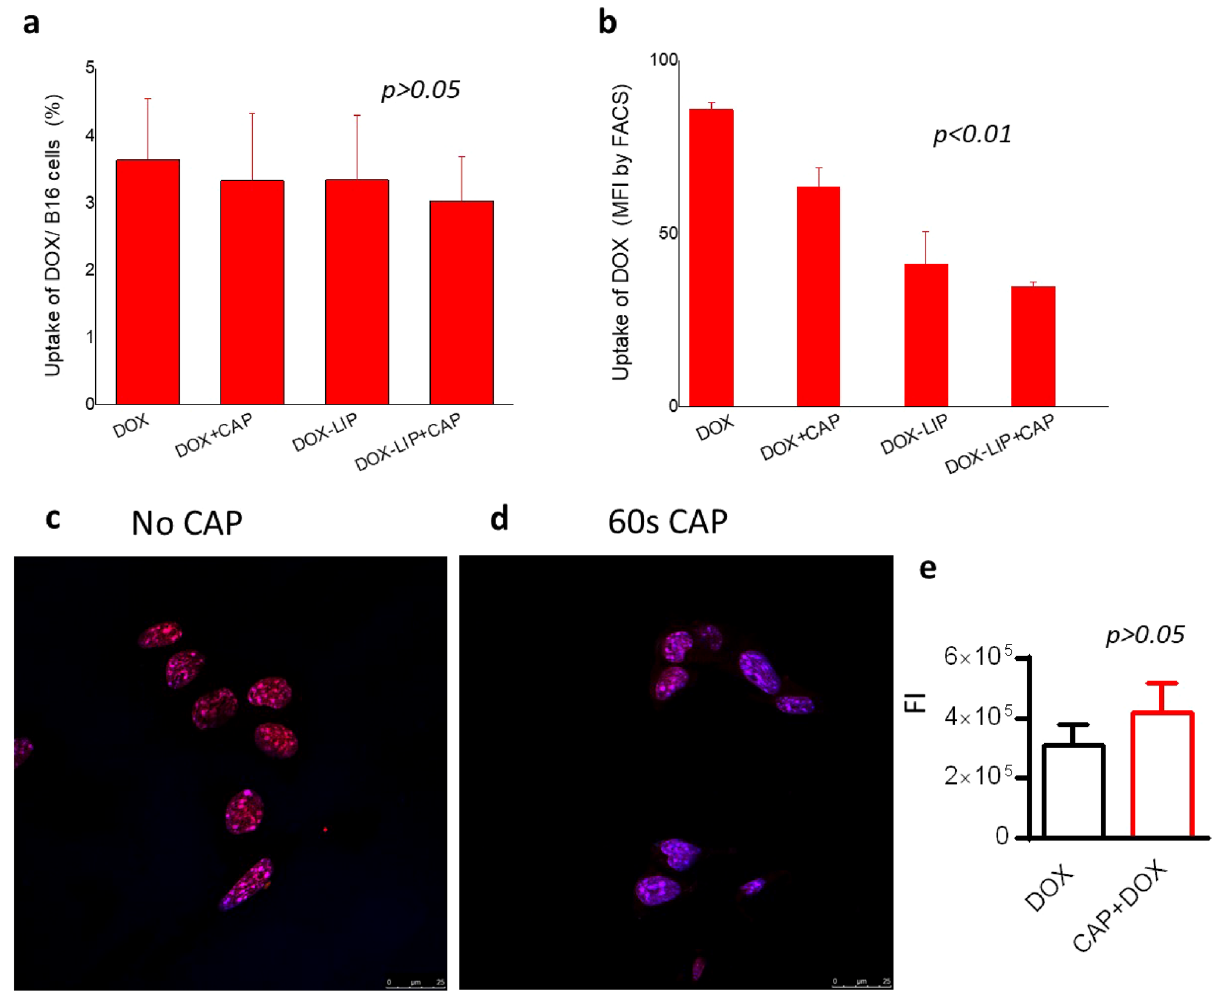
Figure 3. Effect of CAP on the uptake of DOX or DOX-LIP by B16 cells. ( a ) Effect of CAP (60 s) on the uptake of DOX or DOX-LIP by B16 cells after 4 h of co-incubation of cells with 10 μM DOX (free or liposomal) ( b ). Uptake of DOX by cells after 4 h co-incubation (same conditions as those applied in a ), based on FACS measurement’s (Mean Fluorescence Intensity). ( c , d ) Representative LSCM micrographs of B16 cells following incubation with DOX (10 µM) only, or after subjection of the cells to CAP (for 60 s). ( e ) FI values calculated from micrographs by Image J.